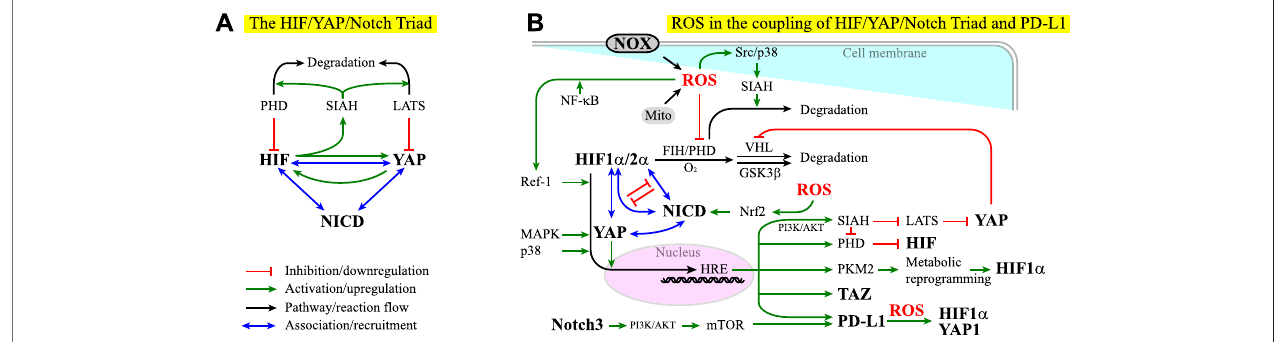
FIGURE 5 | (A) HIF, YAP, and Notch act as a triad in that their effectors can associate to in fl uence each other. See Module Box VI for details. NICD stands for the notch intracellular domain. Red lines indicate inhibition or downregulation. Green lines indicate activation or upregulation. Blue lines indicate physical association or recruitment.Blacklinesindicatethe fl owofthepathwaysorareaction. (B) ROSexhibitbothpositiveandnegativeeffectsonthecouplingoftheHIF/YAP/Notchtriadand PD-L1 signaling. See the main text and Module Box VI for